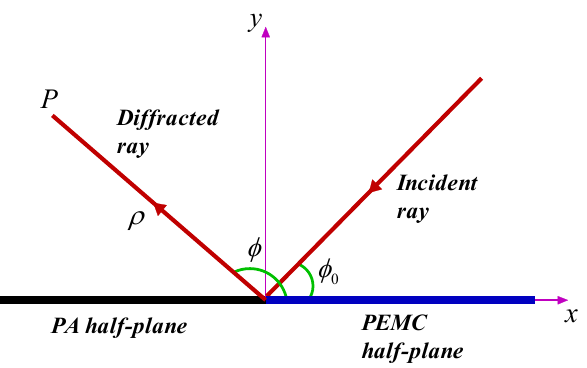
FIGURE 1. The diffraction geometry of waves by a planar junction between PEMC and PA half-planes.